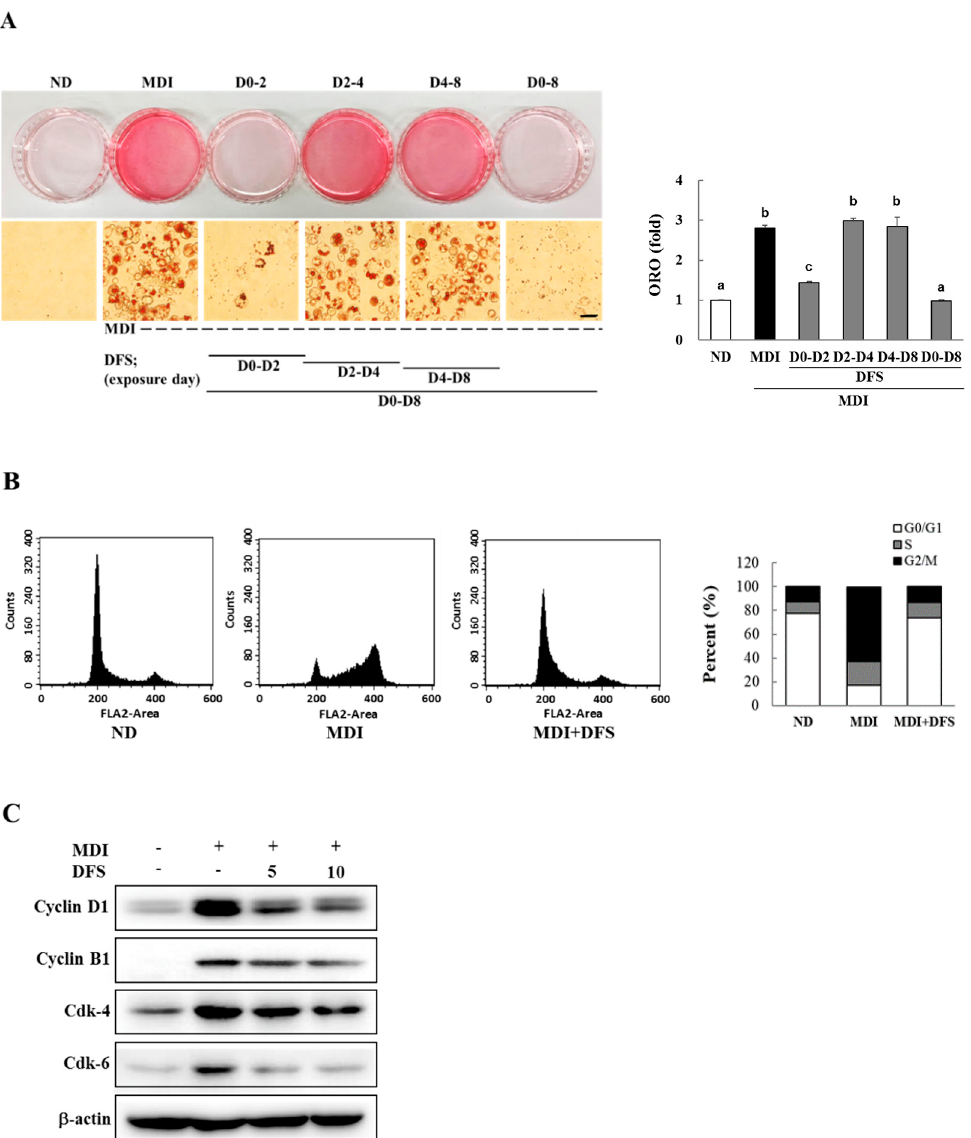
Figure 2. DFS inhibits mitotic clonal expansion during adipocyte di ff erentiation. ( A ) Confluent 3T3-L1 cells were treated with a combination of MDI and DFS (10 µ M) and subjected to ORO staining on D8. Scale bar = 50 µ m. Data are means ± standard deviation (SD) of triplicate experiments. Means without a common superscript di ff er significantly ( p < 0.05). ( B ) Confluent adipocytes were treated with DFS for 48 h followed by flow cytometry. ( C ) Harvested cells on D2 were lysed and subjected to western blotting using indicated